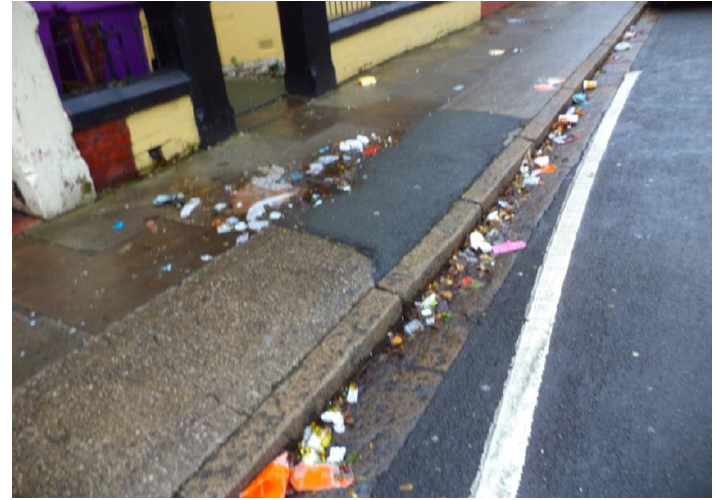
Figure 11. Example of litter in the street hindering respect and social inclusion (P20) (Road,